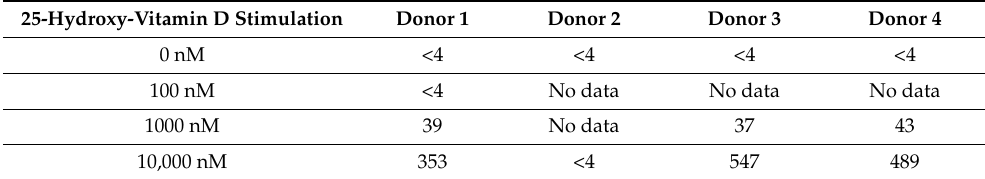
Table 1. Concentrations of 3-epi-25-hydroxy-vitamin D 24 h after stimulation with 25-hydroxy- vitamin D in media from M0